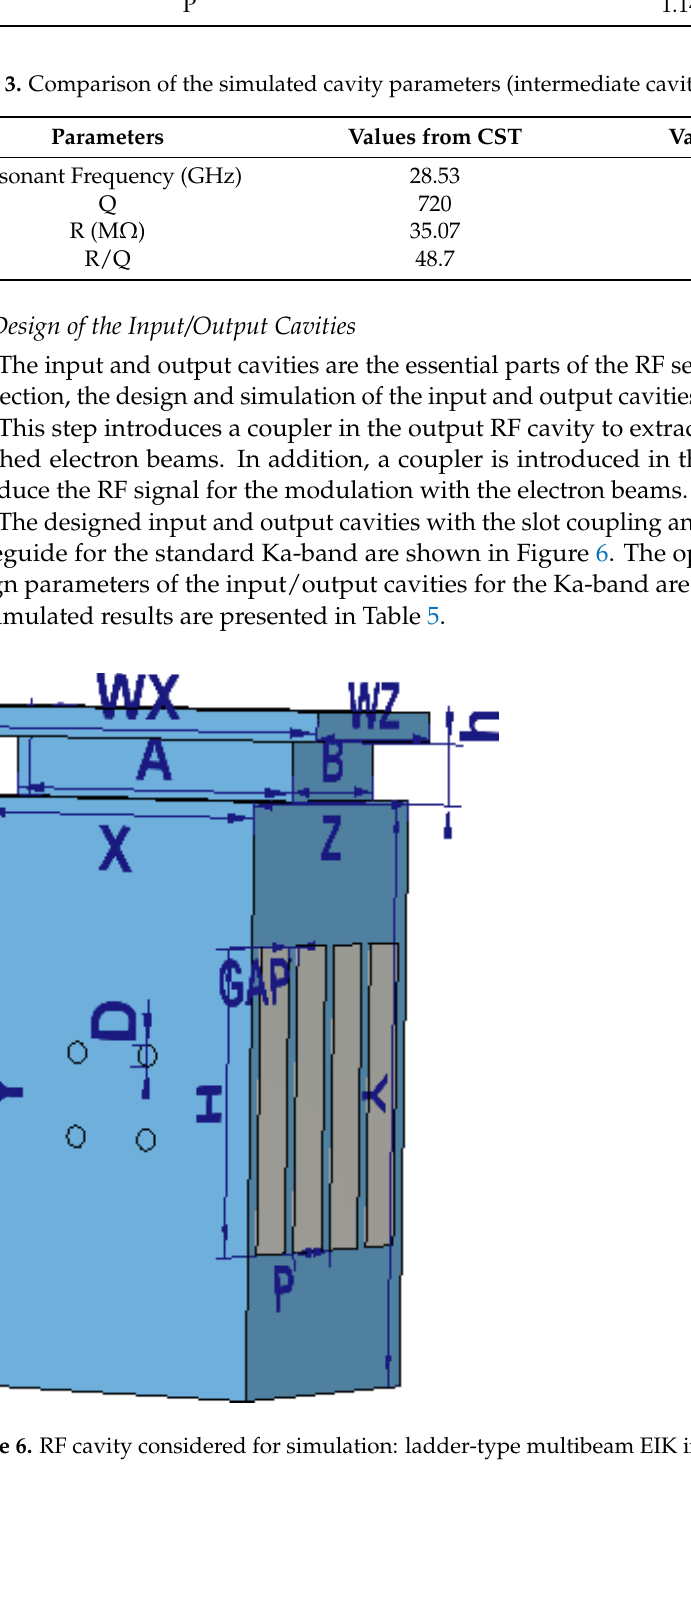
Table 3. Comparison of the simulated cavity parameters (intermediate cavity).